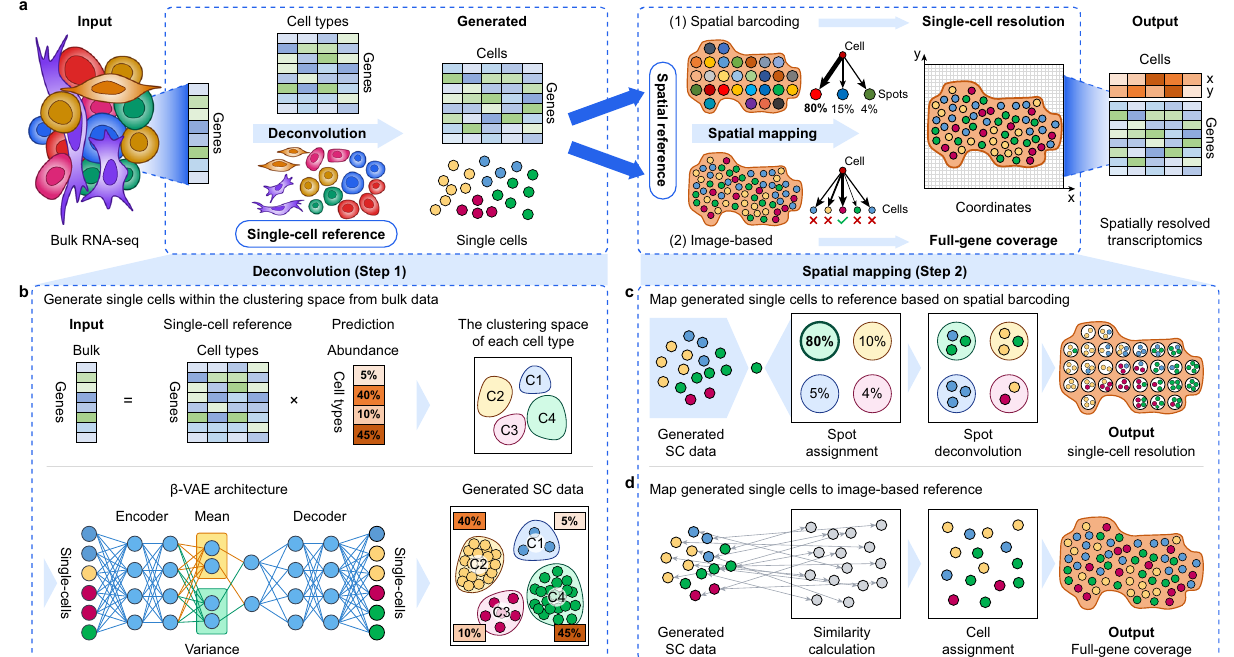
Fig.1|Work fl owofBulk2Space.a OverviewofthedesignconceptofBulk2Space. Bulktranscriptomedataistakenastheinput, andasingle-cellpro fi leisused asthe referenceforcharacterizingtheclusteringspaceoftheheterogeneoustissue.After deconvolution,inputbulkdataisdeconvolvedintosingle-celltranscriptomicsdata. Then, either of the twospatially resolved transcriptomics, spatial barcoding-based RNA-seq or image-based in-situ hybridization, is used as the spatial reference. Generated singlecellsareassignedto the corresponding coordinates based onthe spatialreference. Theoutput is asetofgenerated single-cellpro fi leswith speci fi ed x and y spatial coordinates. b Detailed deconvolution procedure. The input vector of bulk tissue is equal to the production of the expression matrix of cell types and theproportionvectorofeachcelltype.Thecalculatedproportionofallcelltypesis